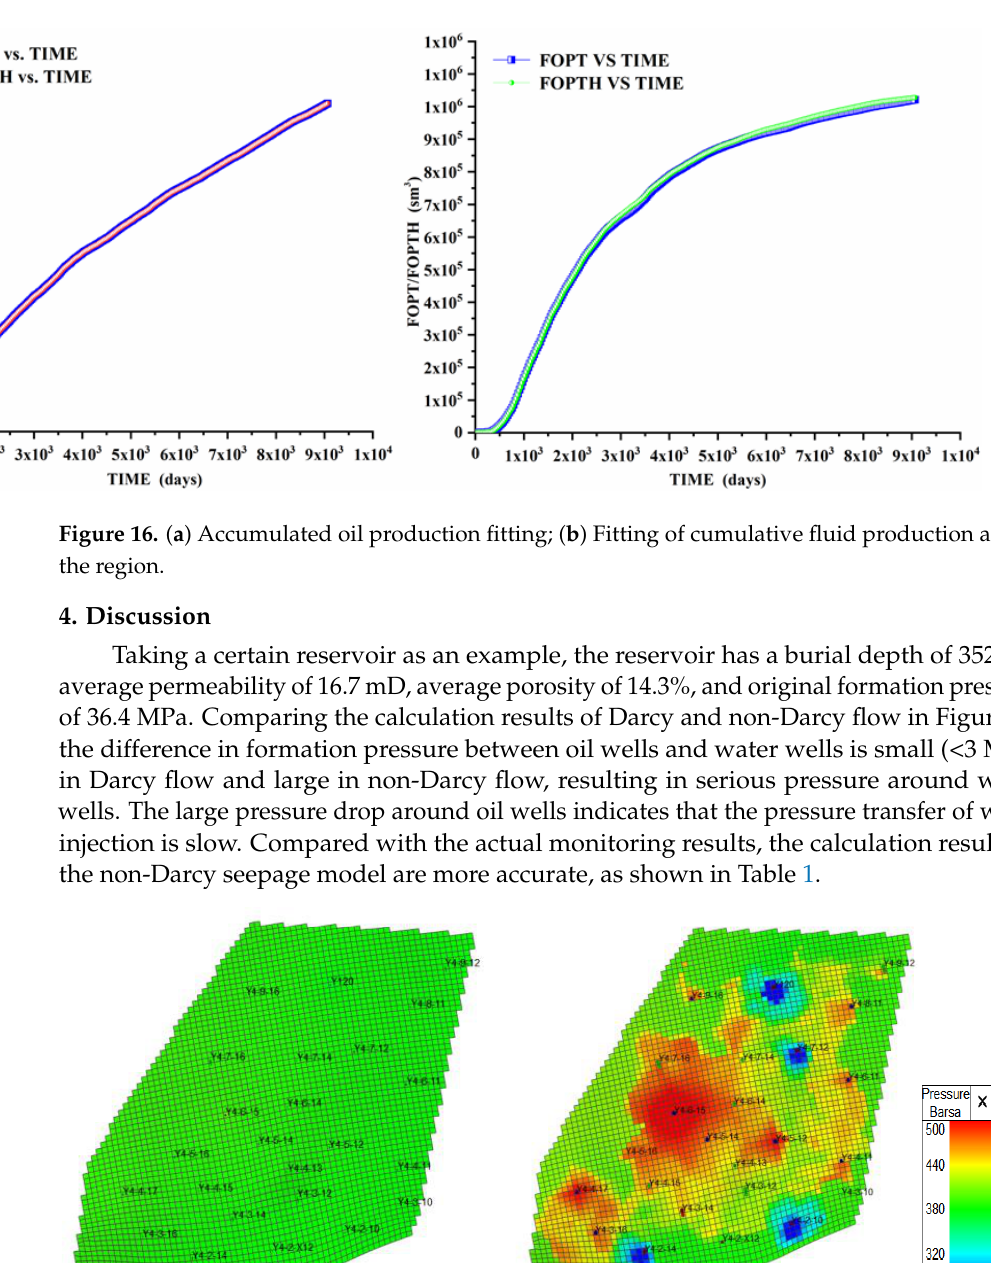
Figure 15. ( a ) Comprehensive water cut fitting; ( b ) fitting of daily oil production in the whole re- gion.